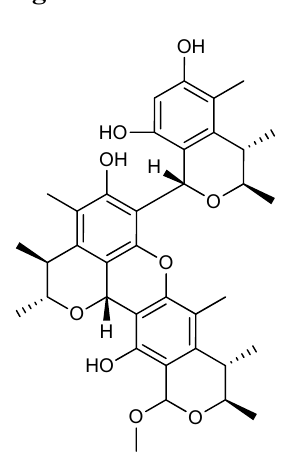
Figure 9. Tricitrinol